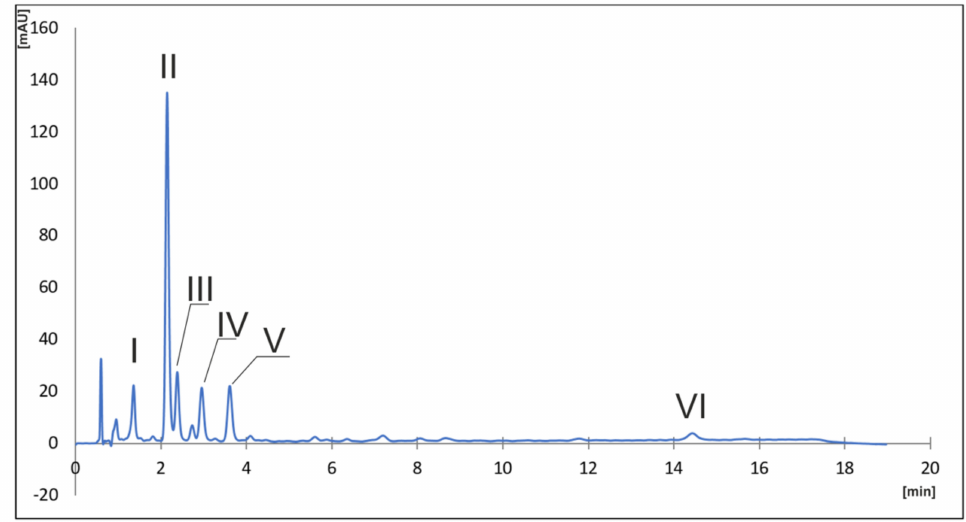
Figure 2. (I) 3 − hydroxypuerarin, t = 1.3 min; (II) puerarin, t = 2.1 min; (III) 3 − metoxypuerarin, t = 2.3 min; (IV) 6 − O − D − xylosylpuerarin, t = 2.9 min; (V) daidzin, t = 3.6 min; (VI) daidzein, t = 14.4